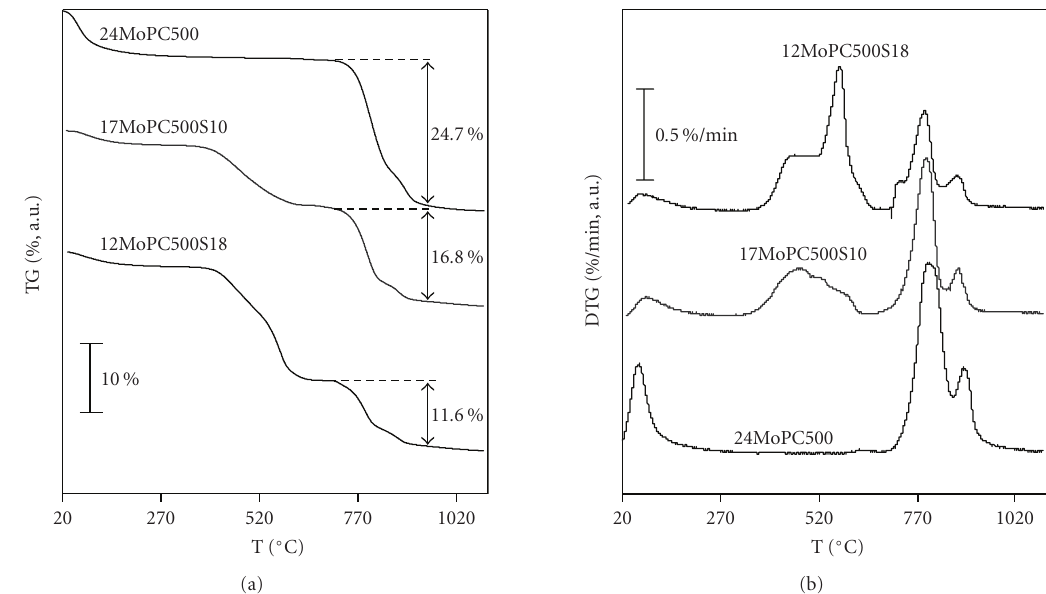
Figure 2: TG (a) and DTG (b) curves of 24Mo PC500, 17MoPC500S10, and 12MoPC500S18 catalysts.